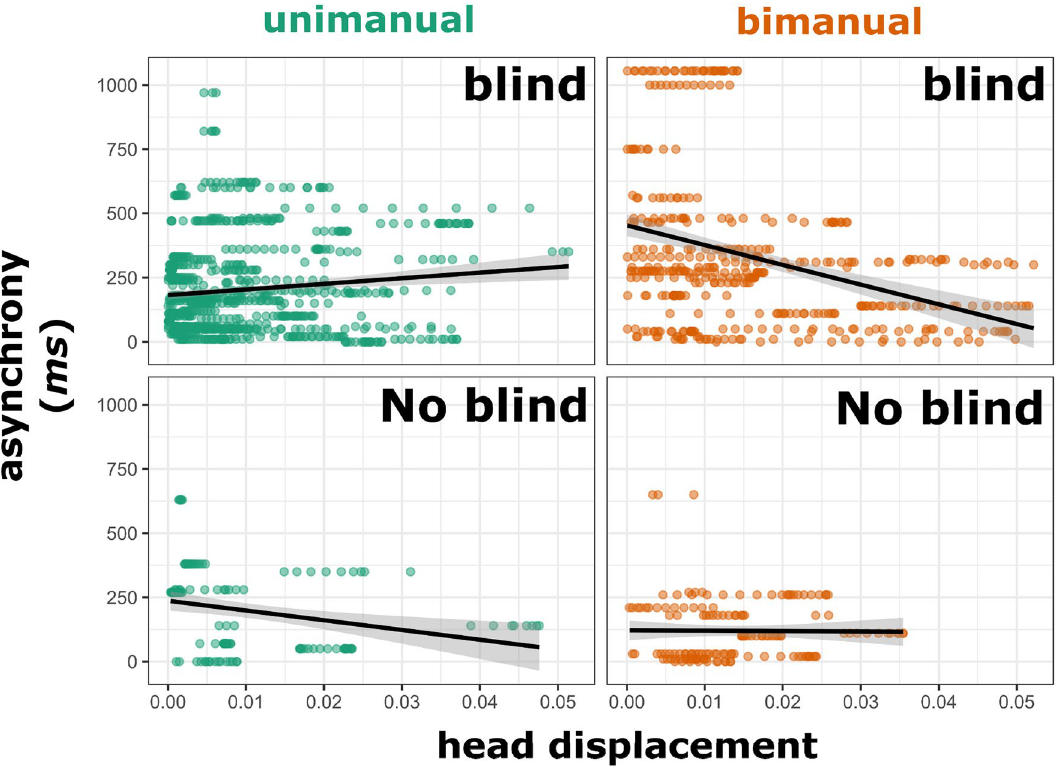
Figure 7. Head displacement versus asynchrony. Note . Head displacement sampled around a peak deceleration of the gesture is given on the x-axis (higher values mean more head displacement). Asynchrony between peak deceleration and peak F0 is given on the y axis (higher values mean more asynchrony, lower values mean more synchrony). It can be clearly seen that for the blind condition there is more synchrony when there is more head displacement, but only for higher impulse bimanual gestures. Not also that more head displacement is recruited in the blind condition as compared to the no-blind condition (in line with the idea that impulses of gestures are recruited as a resource). For the no-blind condition the relationship between head displacement and asynchrony seems to only hold for the unimanual